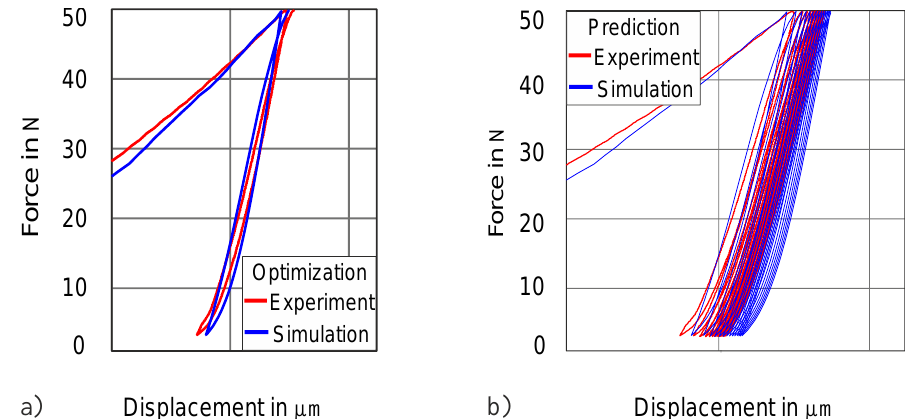
Figure 8. ( a ) Simulated force – displacement loop. ( b ) Predicted force – displacement for 13 cycles.